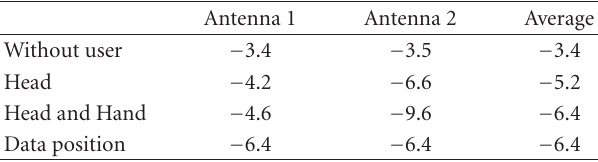
Table 4: The MEG in d B evaluated for the MIMO